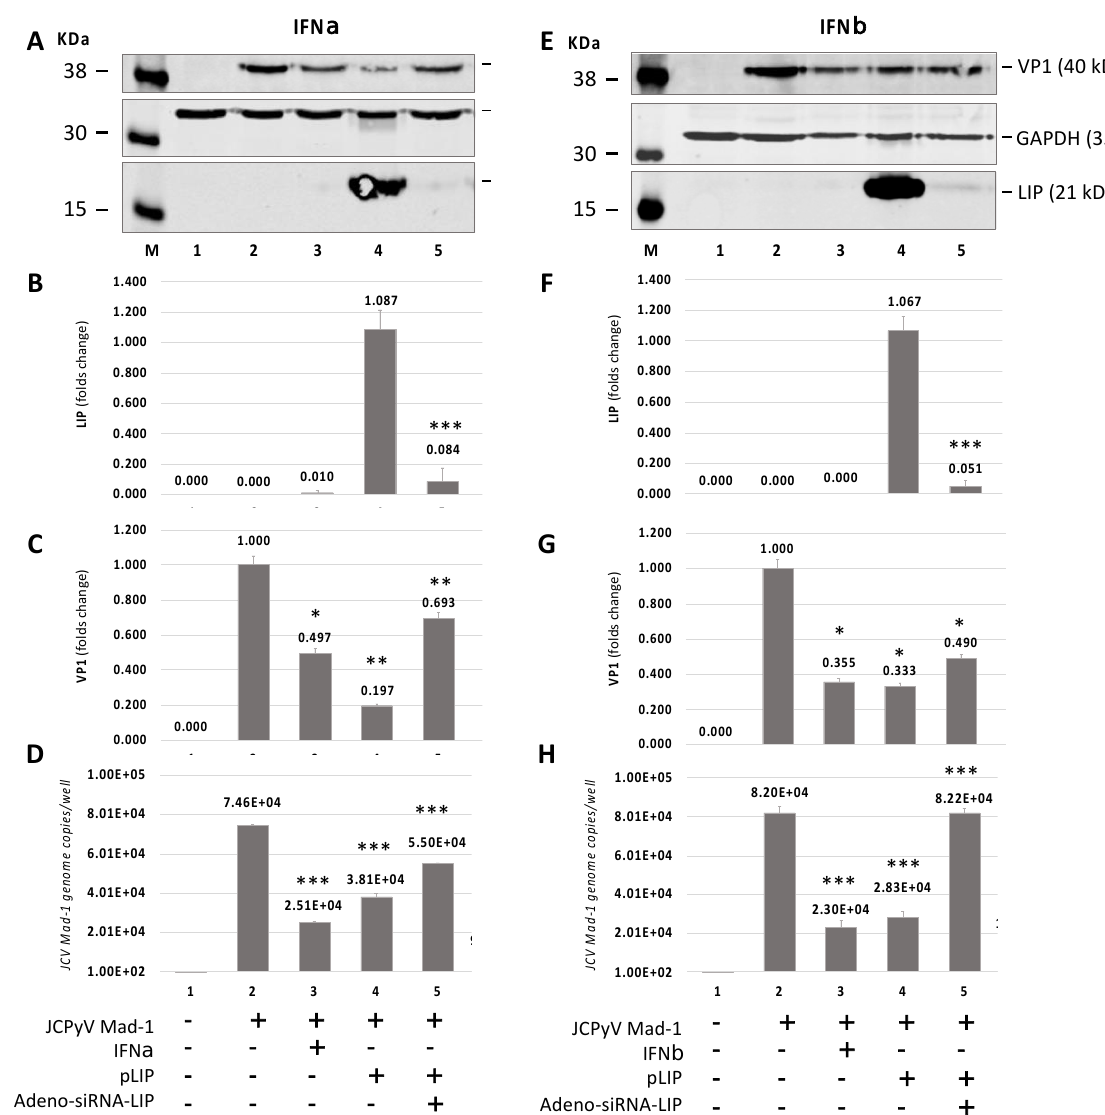
Figure 4. Effect of Adeno-siRNA-LIP on JCPyV-infected SVGA cells transiently transfected with C/EBP β -LIP expression plasmid in presence or absence of IFN α or IFN β treatment. Western blot on protein lysis from SVGA cells co-infected with JCPyV Mad-1 at MOI of 1 and Adeno-siRNA-LIP at MOI of 5 after co-transfected with pLIP and treatment with IFN α ( A – D ) or IFN β ( E – H ) for 5 days. On the 5th day post-infection (p.i.), the cells were harvested in order to evaluate the expression of LIP ( B , F ) and the late capsid protein VP1 ( C , G ) by Western blot and to measure the viral load in the supernatant culture media by quantitative PCR (Q-PCR) (D and H). Note: * p <0.05; ** p < 0.01; *** p < 0.0001